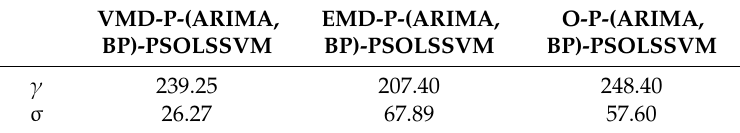
Table 9. Optimal parameters obtained by particle swarm